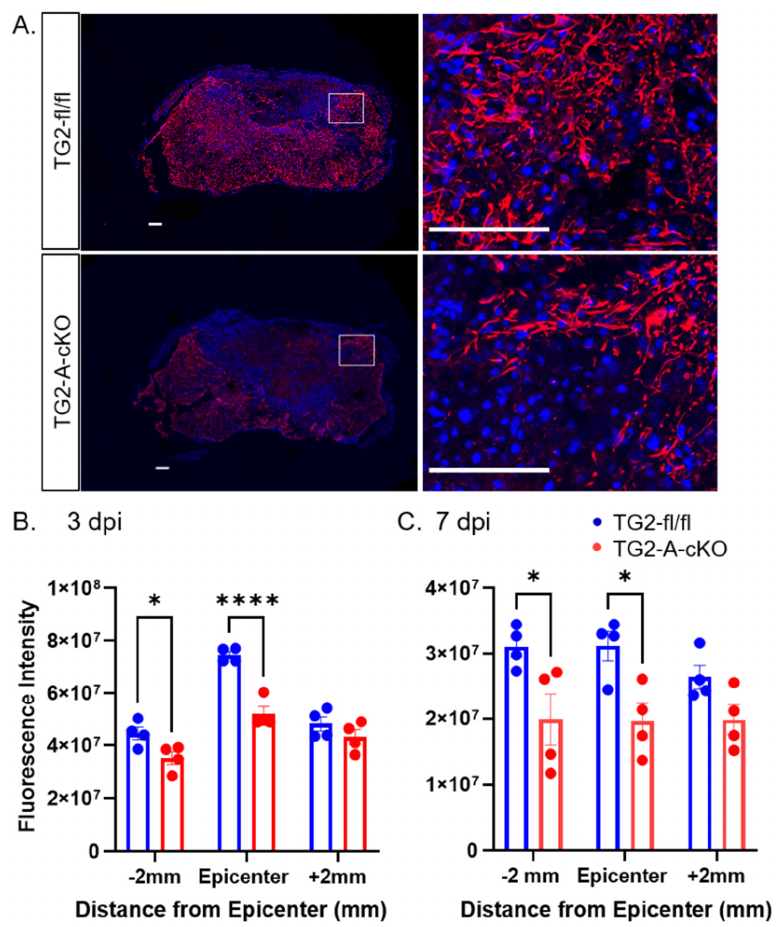
Figure 2. GFAP Expression is significantly reduced at the lesion site in TG2-A-cKO at 3 and 7 days after spinal cord contusion injury. ( A ) Representative images of 7 days post-injury (7 dpi) at the epicenter of the injury. Spinal cord sections were immunostained for GFAP (red) and counterstained with DAPI (blue). At the right are enlargements of the boxed areas in the images at the left. Scale bars = 100 µ m. ( B , C ) Quantified GFAP immunoreactivity. GFAP expression was significantly lower − 2 mm and at the epicenter in the TG2-A-cKO mice at both 3 and 7 dpi. N = 4 animals per group. * p < 0.05, **** p <